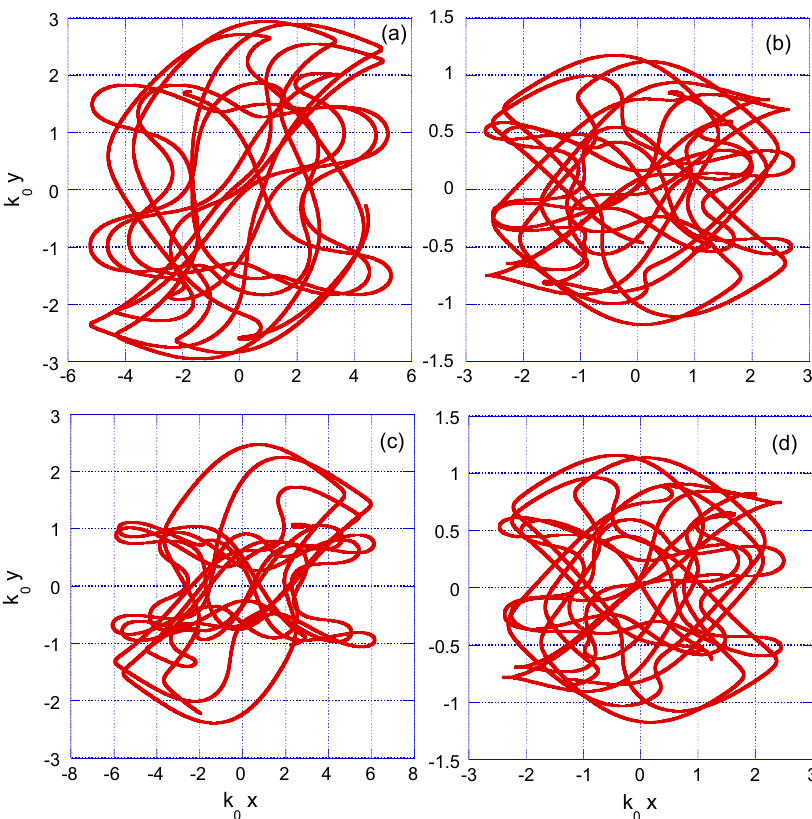
Figure 7. Parametric plots of normalized y ( t ) vs. x ( t ) in the four cases of Figure 6. k 0 × x ( t ) and k 0 × y ( t ) are dimensionless variables. Projections of trajectories onto the xy -plane are considerably more complex than in case-study 1, compare with Figure 2.